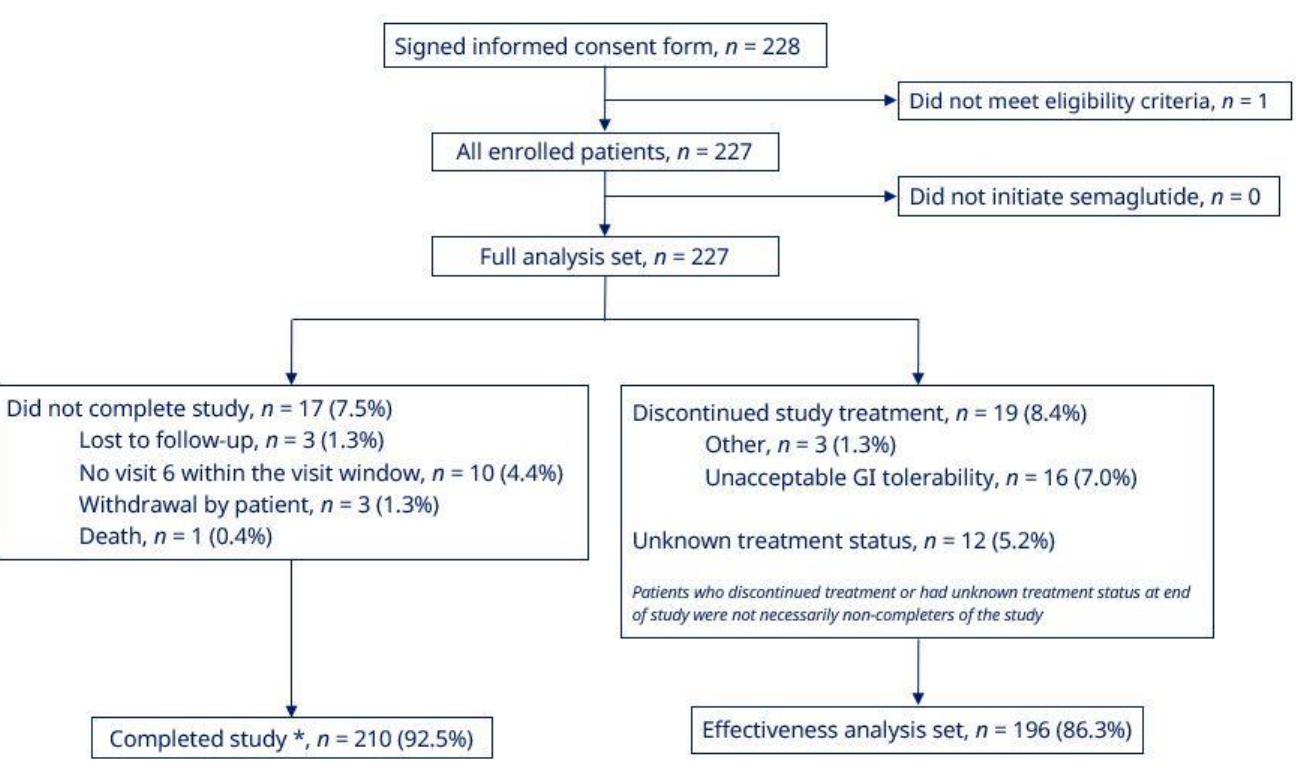
Figure 1. Patient disposition. * Patients who initiated semaglutide treatment and attended the end of study visit. GI, gastrointestinal